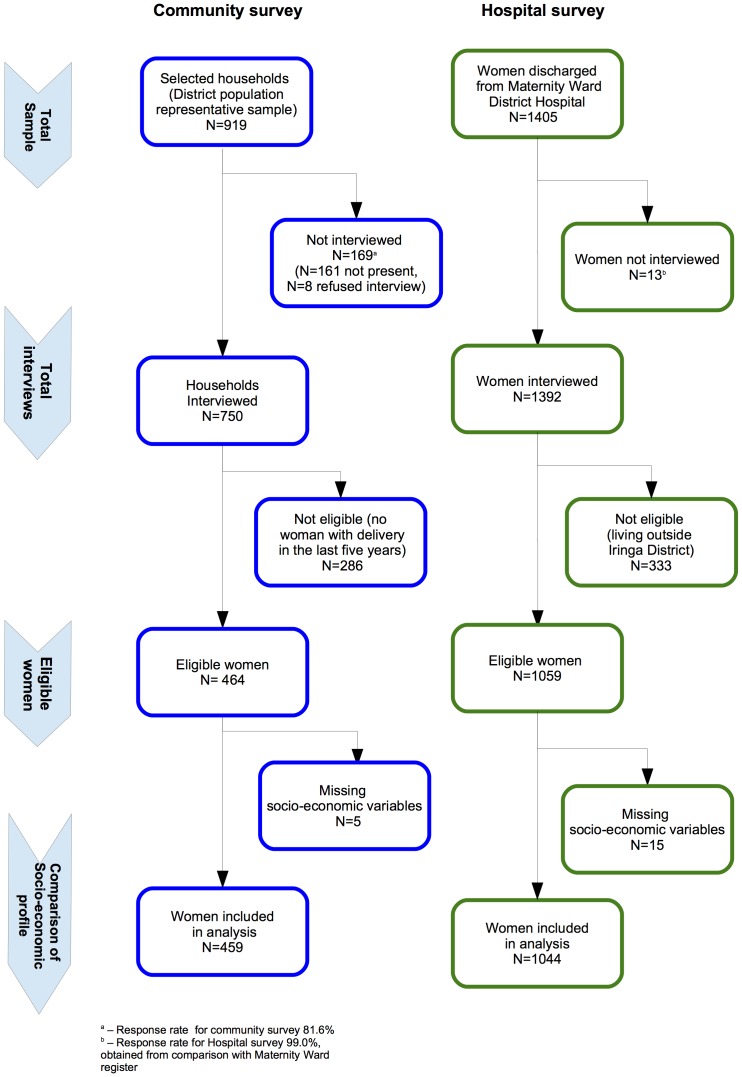
Data flow for the community and hospital surveys.